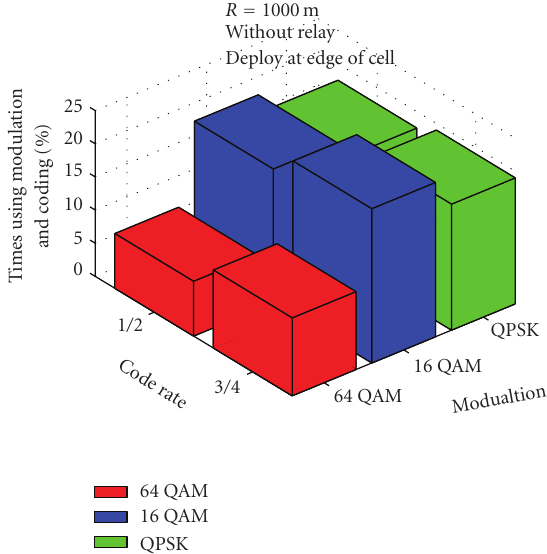
Figure 18: Combination of modulation and coding (without relays).